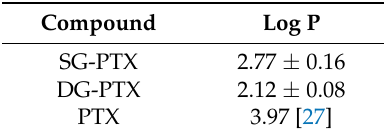
Table 2. Log P determination of SG-PTX, DG-PTX, and PTX. All values are expressed as mean ± SD (n =